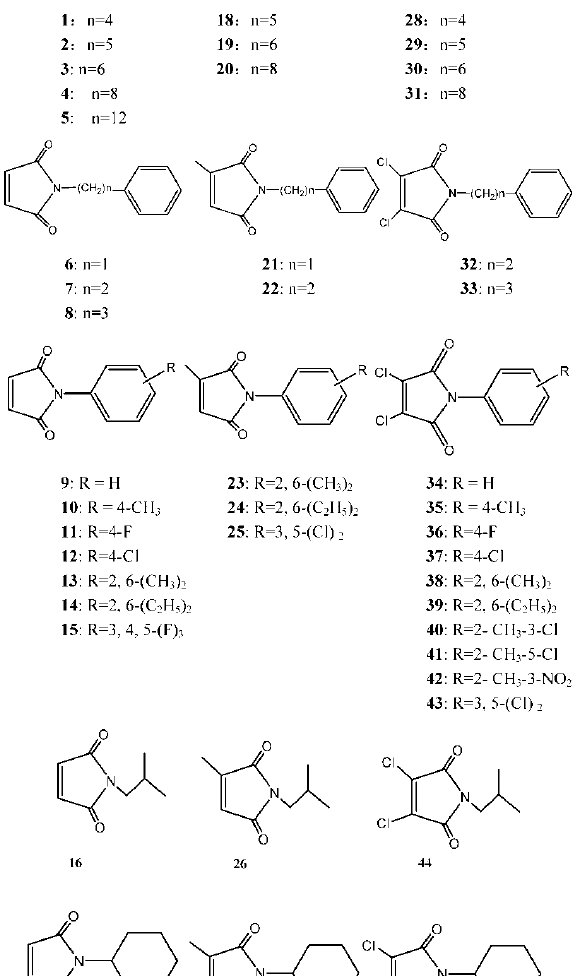
Figure 2. The chemical structure of pentamidine.